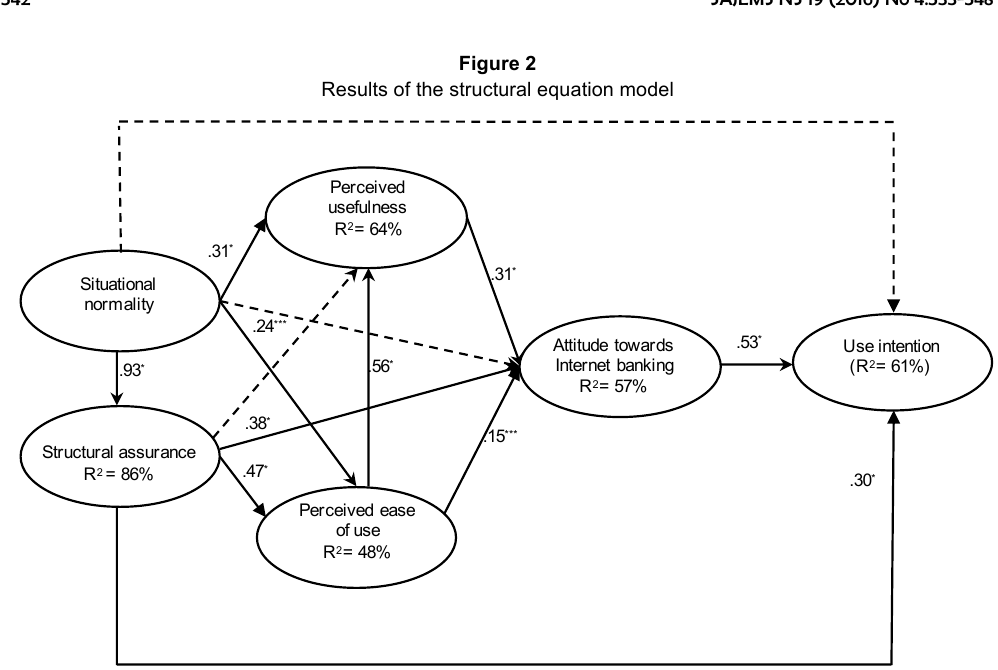
Figure 2 Results of the structural equation